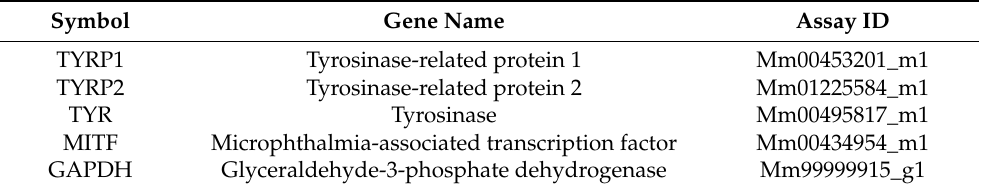
Table 1. Gene name and assay ID number in real-time RT-PCR